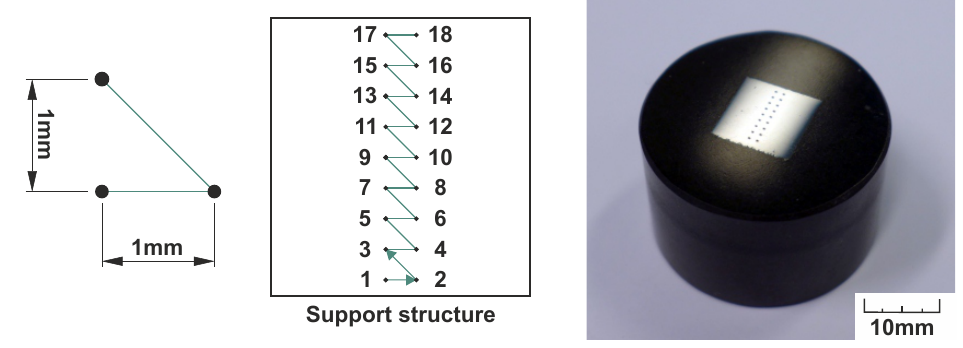
Figure 8. Pattern of hardness